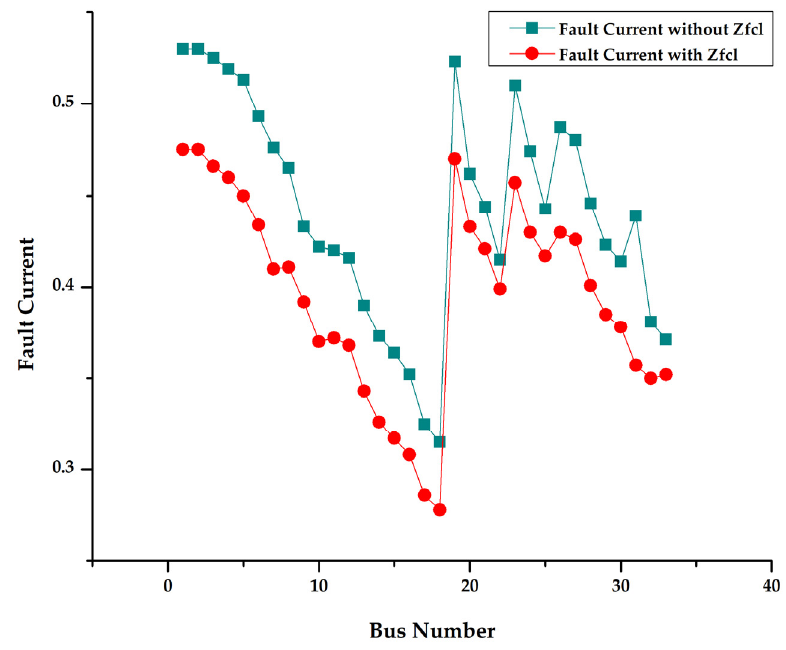
Figure 5. Representation of Z fcl fault current minimization.